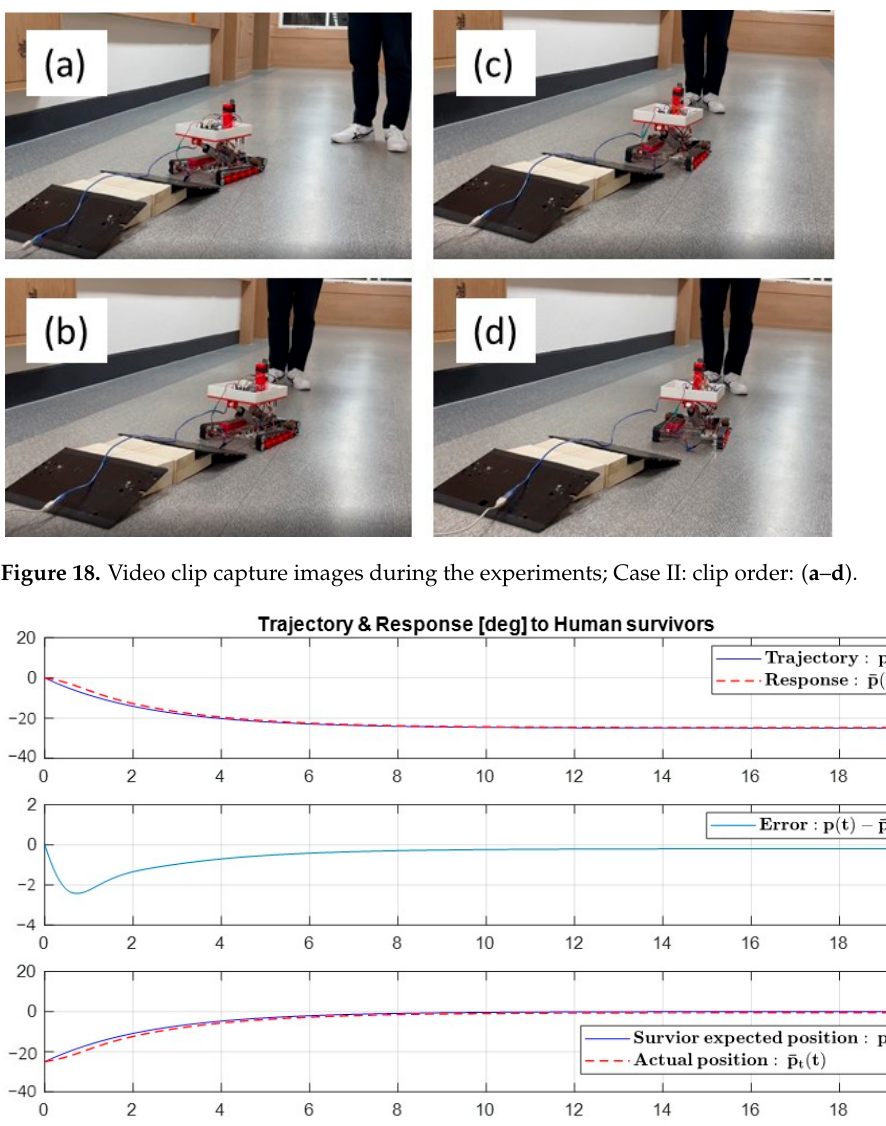
Figure 19. Experiential results of Case II: target trajectory vs. resulting trajectory and target orienta- tion vs. resulting orientation.